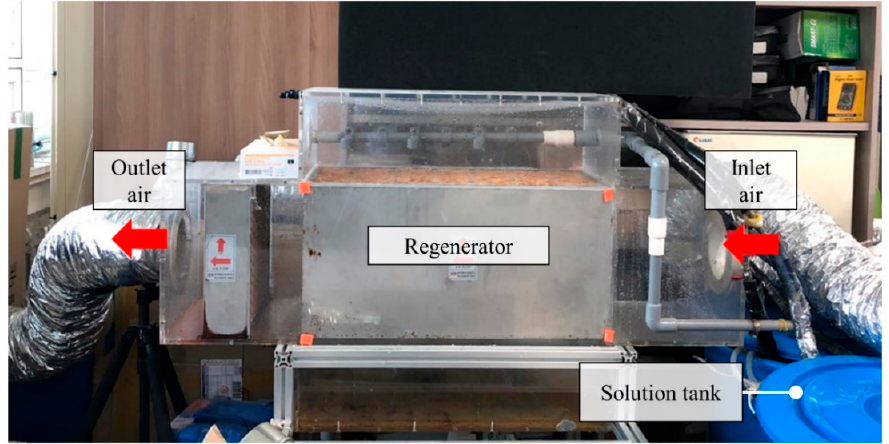
Figure 6. Actual experimental setup of REG. Table 1. Physical information of each component in the experimental setup.